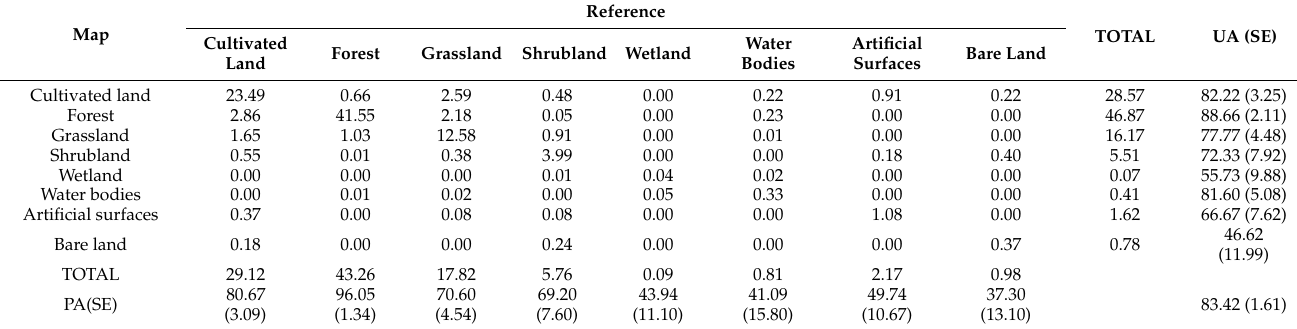
Table A8. Error matrix of fused product 2010 using random forest.